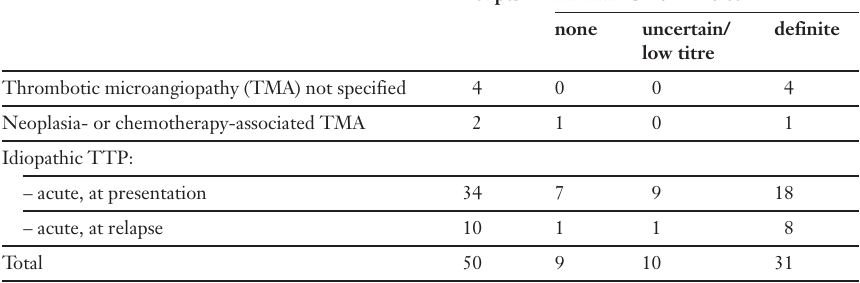
Detection of in- hibitory autoanti- bodies in patients with severe ADAMTS-13 defi- ciency (<5% of